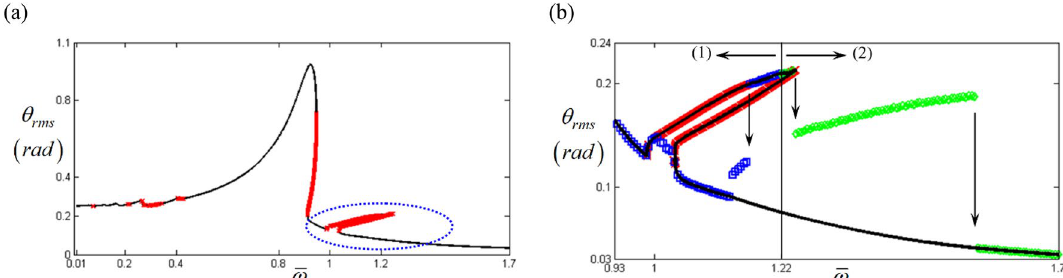
Figure 4. Nonlinear frequency response with RMS reflecting sub-harmonic resonance: ( a ) the HBM result under unstable conditions with sub-harmonic resonance; ( b ) comparison of HBM with NS by focusing on the specific stable regime. Key: Black line, HBM result; Red times , HBM result under unstable conditions; Blue square, NS results with frequency down-sweeping; Green diamond, NS results with frequency up-sweeping.